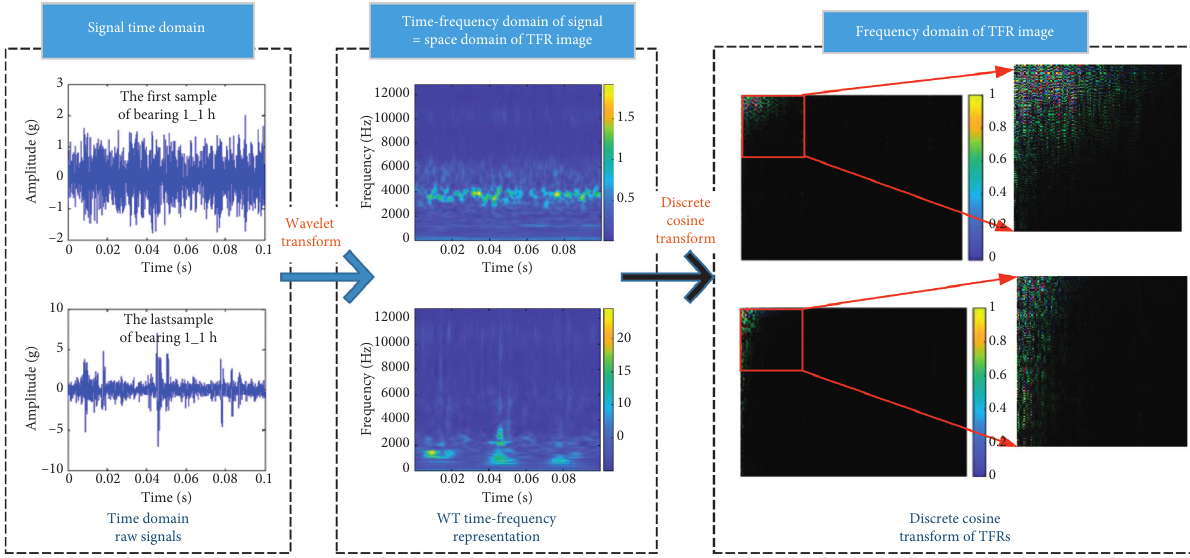
Figure 8: Illustration example of the procedure of RUL preprocessing. Table 2: Topology of the sparse